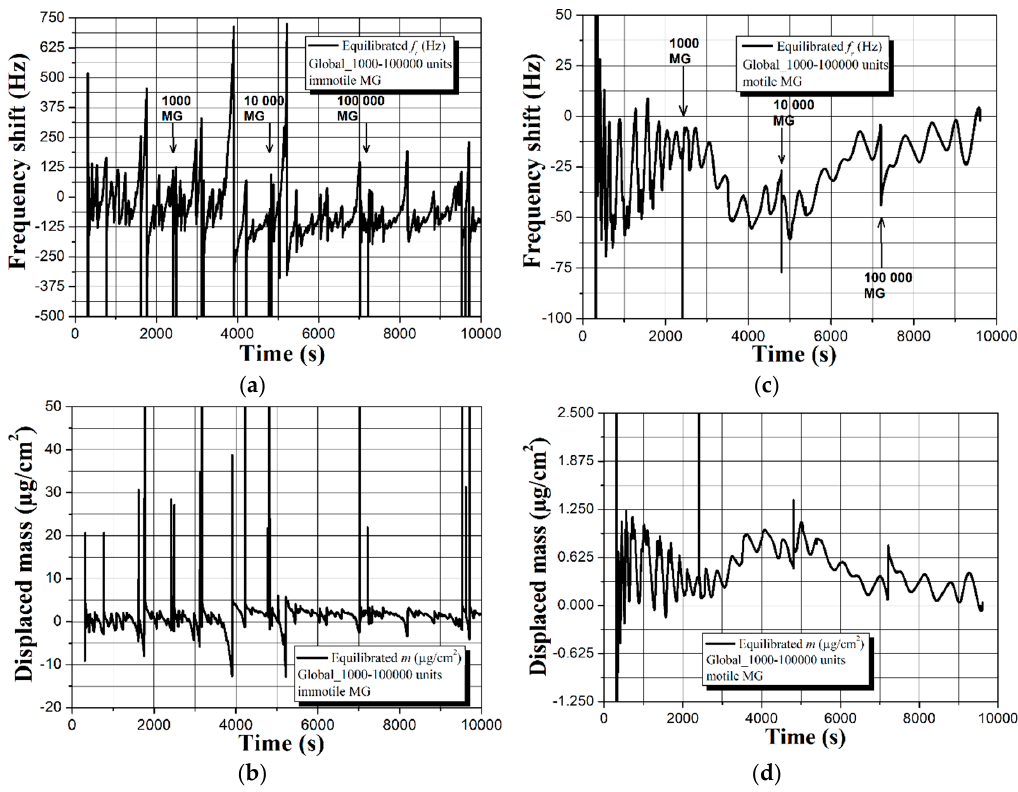
Figure 3. Real-time sensor response of an uncoated 5 MHz QCM to ( a , b ) immotile and ( c , d ) progressively motile human spermatozoa with gradually increasing concentration. All graphs reflect actual biomass effects and/or possible viscosity-density changes after equilibration of the baselines in Global